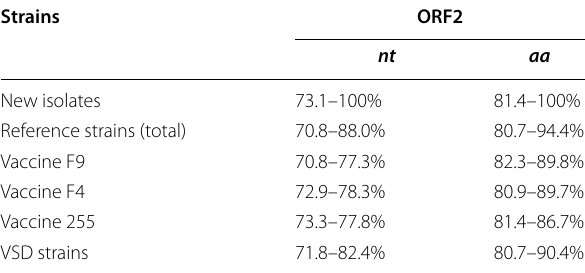
Table 3 Sequence homology of FCV ORF2 Strains